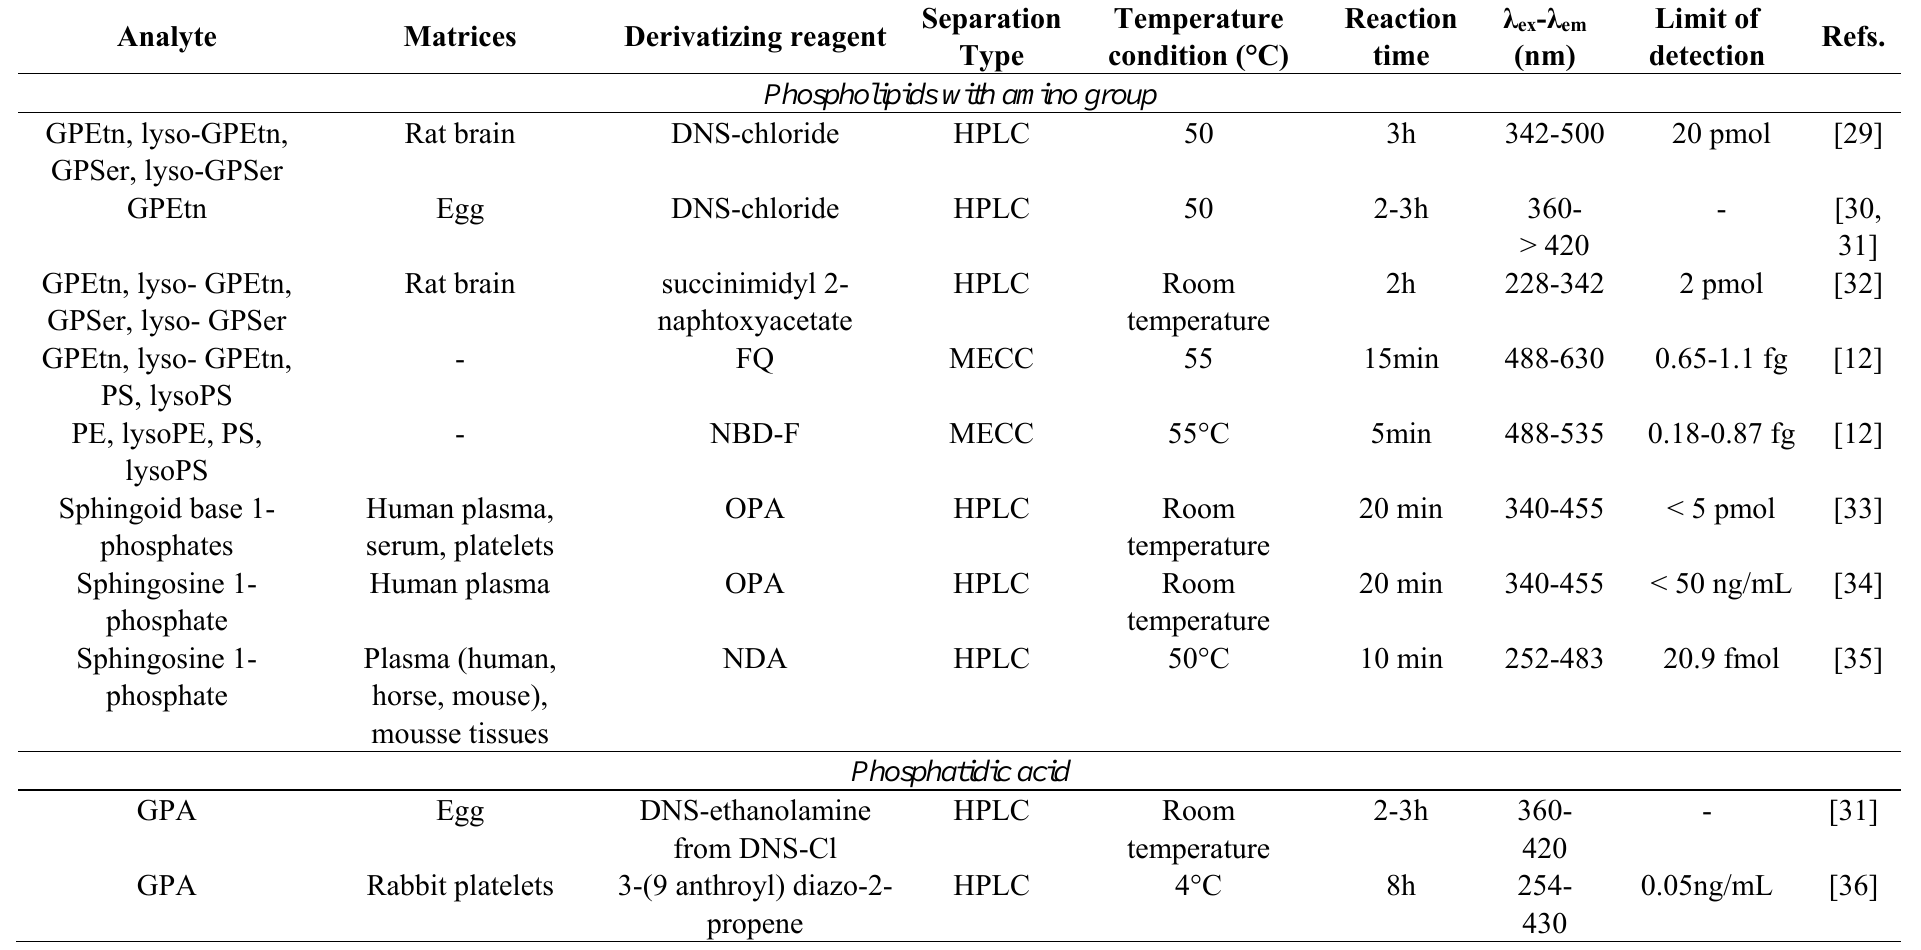
Table 1. Fluorescence derivatizations used in HPLC and CE with DNS-chloride: 1-dimethyl-aminonaphthalene-5-sulfonyl chloride, FQ: